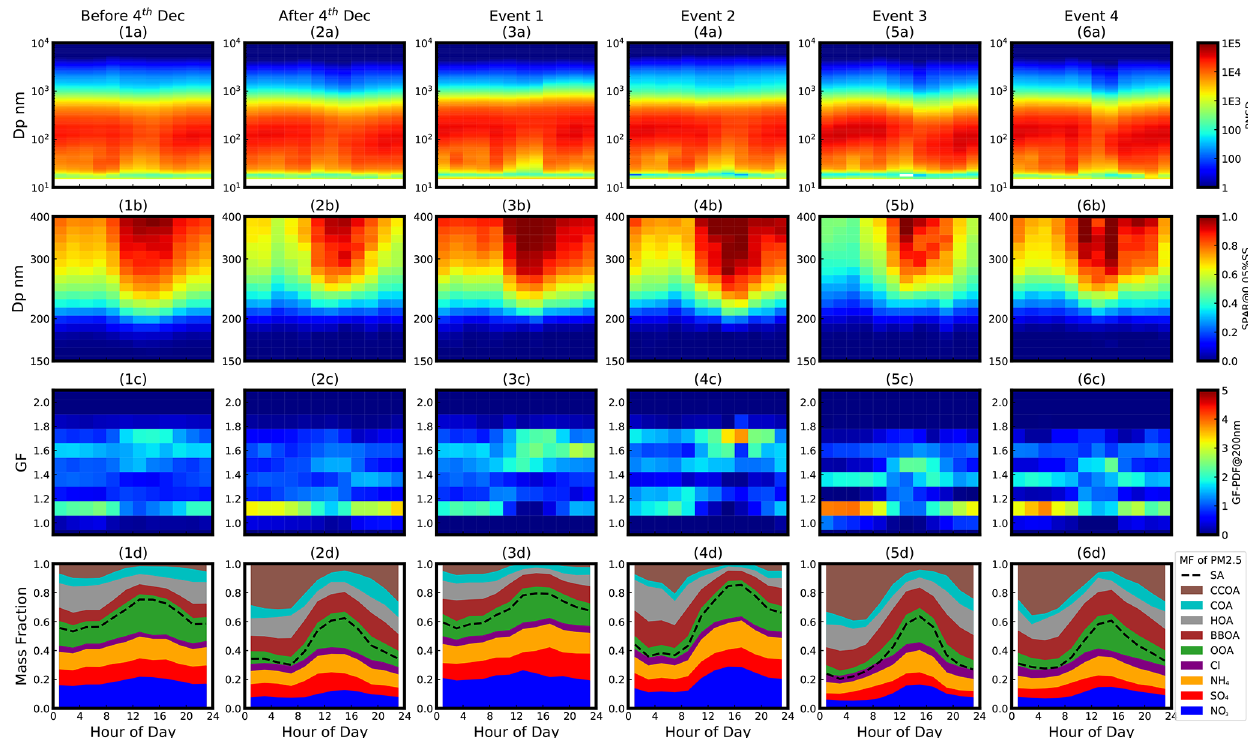
Figure 2. Diurnal variation of (a) PNSD, (b) SPAR at SS of 0.05%, (c) GF-PDF at 200nm and (d) mass fraction of different PM 2 . 5 chemical species during high RH periods before 4 December (1), low RH periods after 4 December (2) and the four events (3–6), including OA factors: hydrocarbon-like OA (HOA), cooking OA (COA), biomass burning OA (BBOA), coal combustion OA (CCOA) and oxygenated OA (OOA).